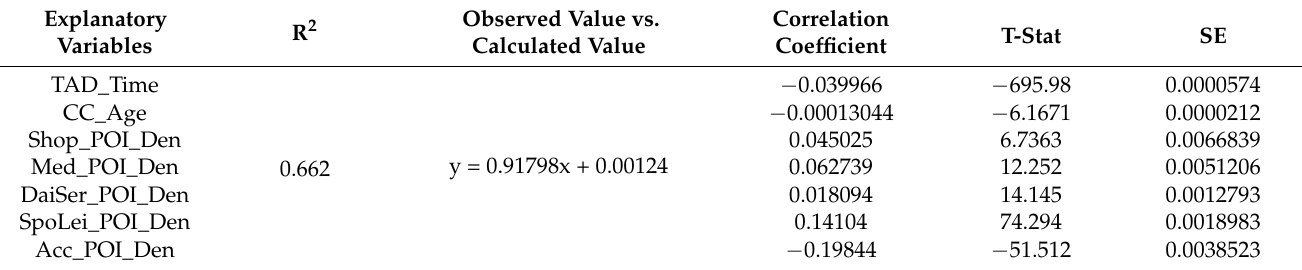
Table 6. Optimal model results for consumers over